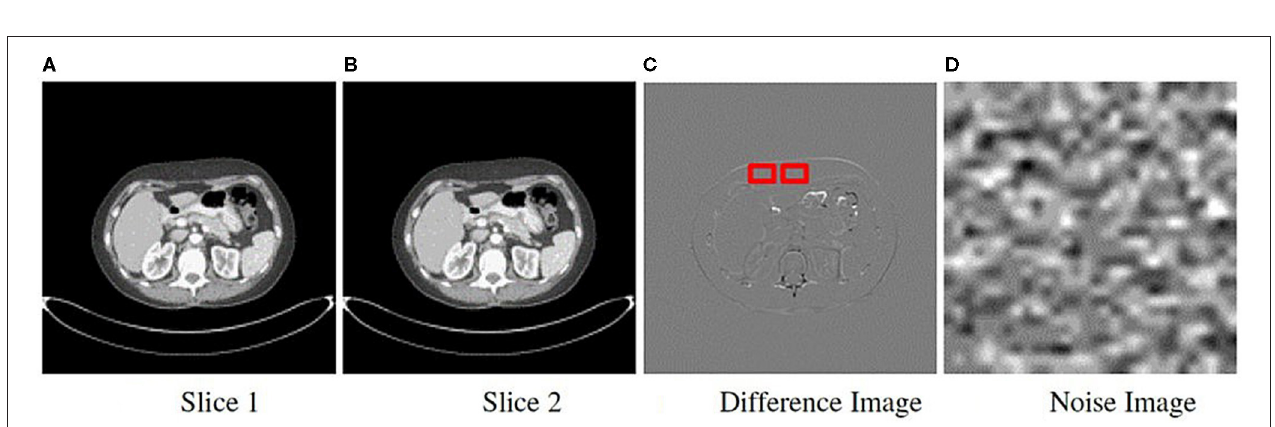
FIGURE 2 | CTNet architecture. CTNet takes as input a volumetric CT scan and outputs a classification prediction. Features are extracted from each slice of the CT scan by the Inception v4 network. The output feature vector is then reduced in dimension with a single convolutional layer, followed by an adaptive average pooling operation applied over the number slices. The resulting vector is fed into a fully connected layer, which has a single output.